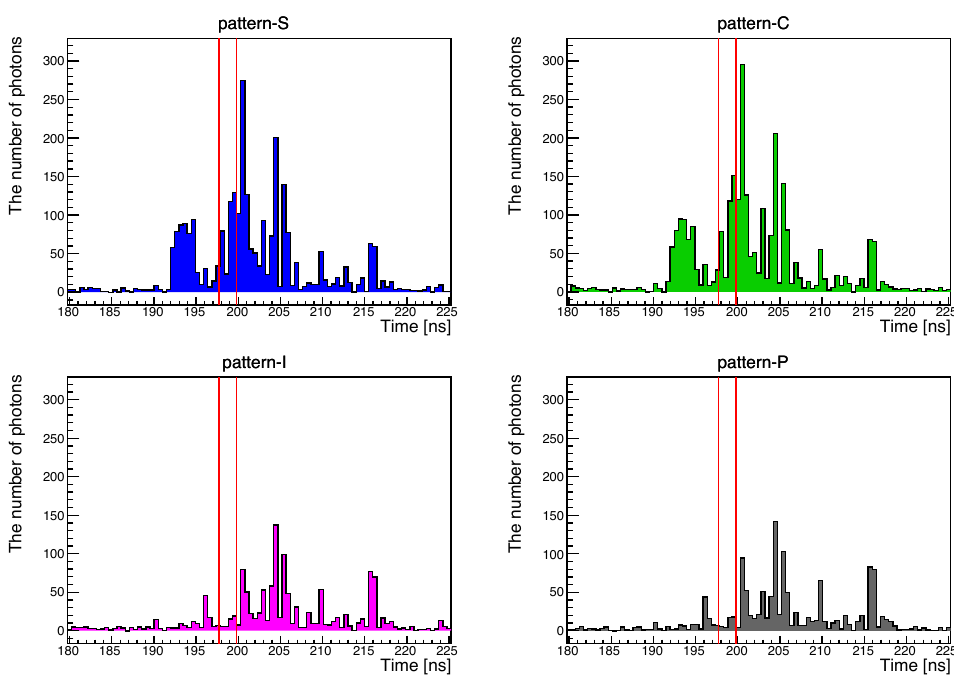
Figure 8. Arrival time distributions of photons with no target state (air) at IP. The histograms in the upper left, upper right, lower left, and lower right correspond to S, C, I, and P patterns of beam combinations, respectively. The interval between the two red lines in the S-pattern indicates the expected time windows for FWM photons via ALP-exchange to arrive.